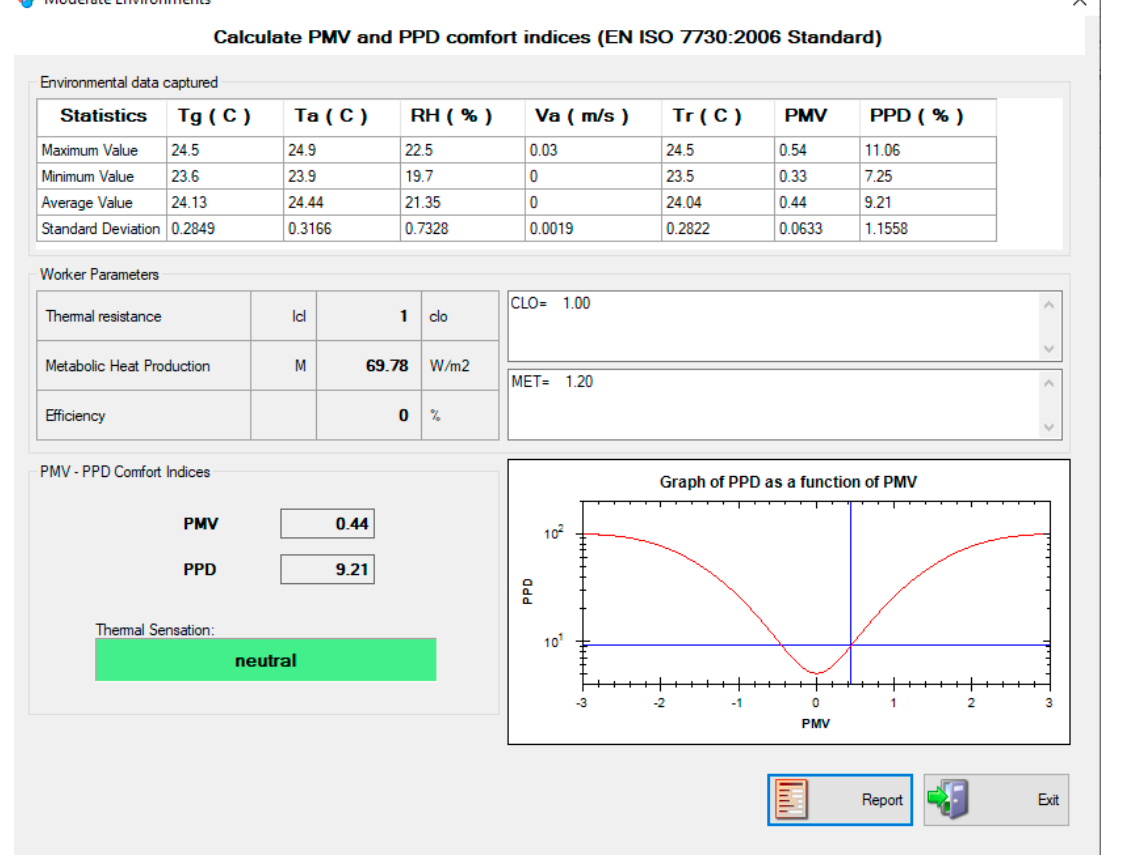
Figure A2. Screen capture of DeltaLog 10 software showing the data acquisition performed during the practical works of Group D.